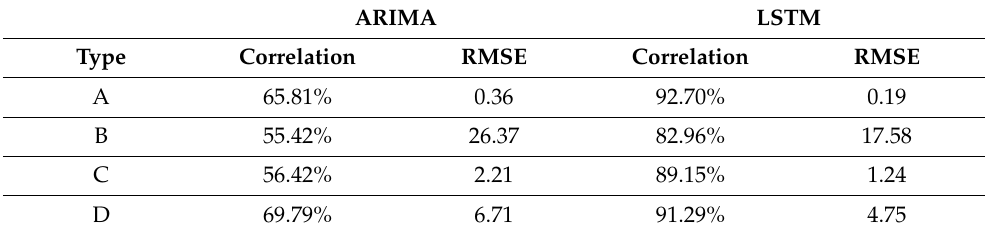
Table 7. Performance evaluation of each model (test dataset).